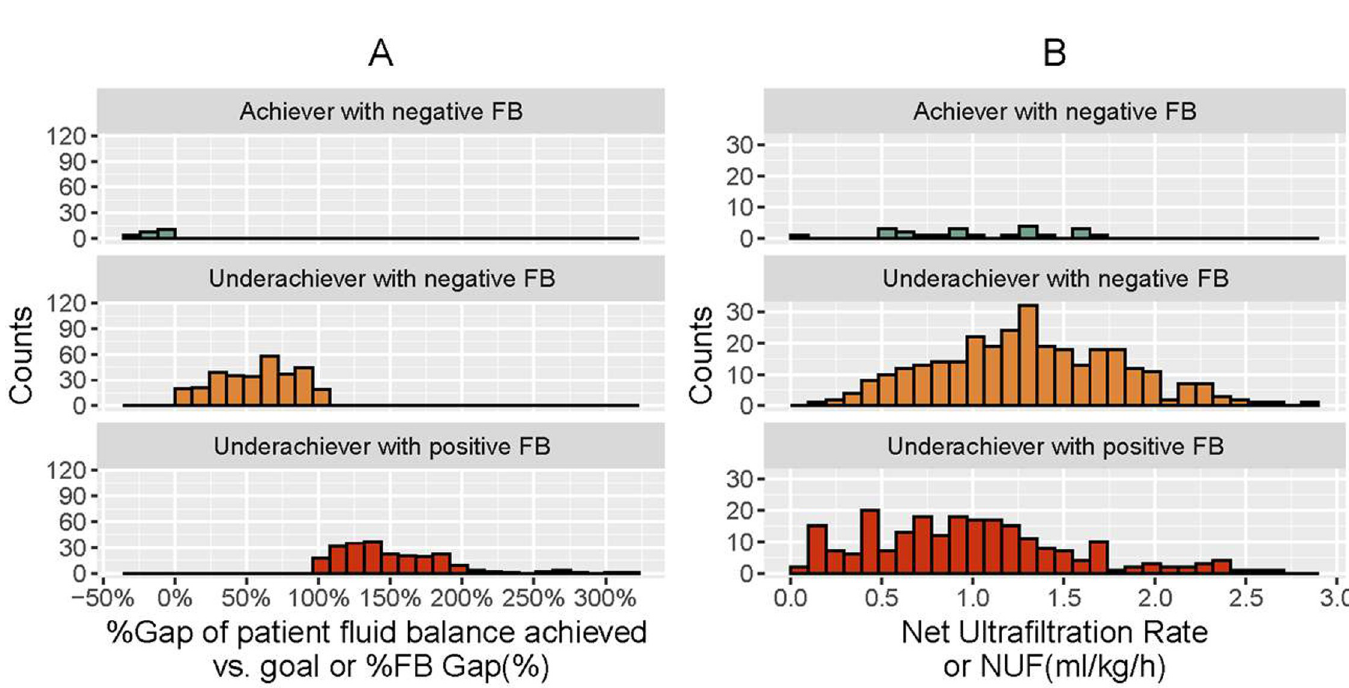
Fig 4. Graphic representation of %FB Gap (Panel A) and NUF (ml/kg/h, Panel B) classified in 3 clinical subgroups: 1) underachiever with positive fluid balance (red); 2) underachiever with negative fluid balance (orange); and 3) achiever with negative fluid balance (green). Note that %FB Gap better differentiate the 3 clinical subgroups than NUF. For visualization, data represented in the Figure exclude < 2.5 and > 97.5 percentiles.